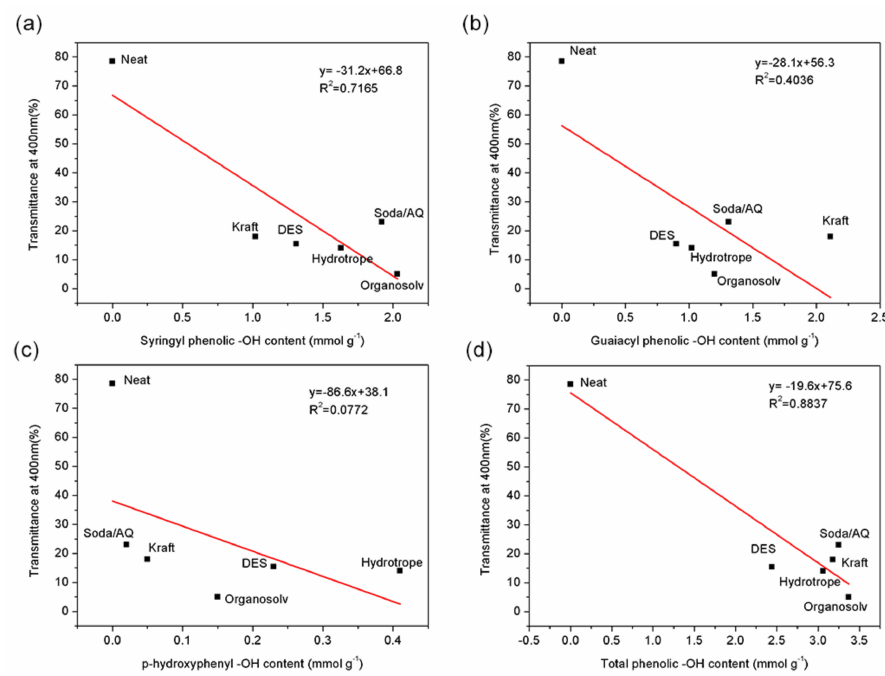
Figure 5. Relationship among transmittance at 400 nm of composite films and the content of ( a ) syringyl phenolic hydroxyl groups, ( b ) guaiacyl phenolic hydroxyl groups, ( c ) p-hydroxyphenyl phenolic hydroxyl groups and ( d ) total phenolic hydroxyl groups of those five